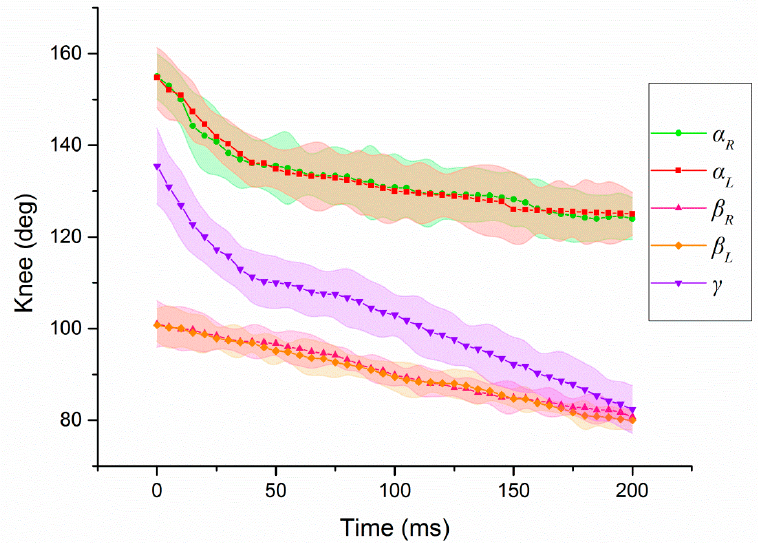
Figure 3. Variation trend of human body angle during the balancing stage, where α L represents the angle of the left knee, α R the angle of right knee, β L the angle of left ankle. β R the angle of right ankle. γ represents the angle between the torso and landing slope .